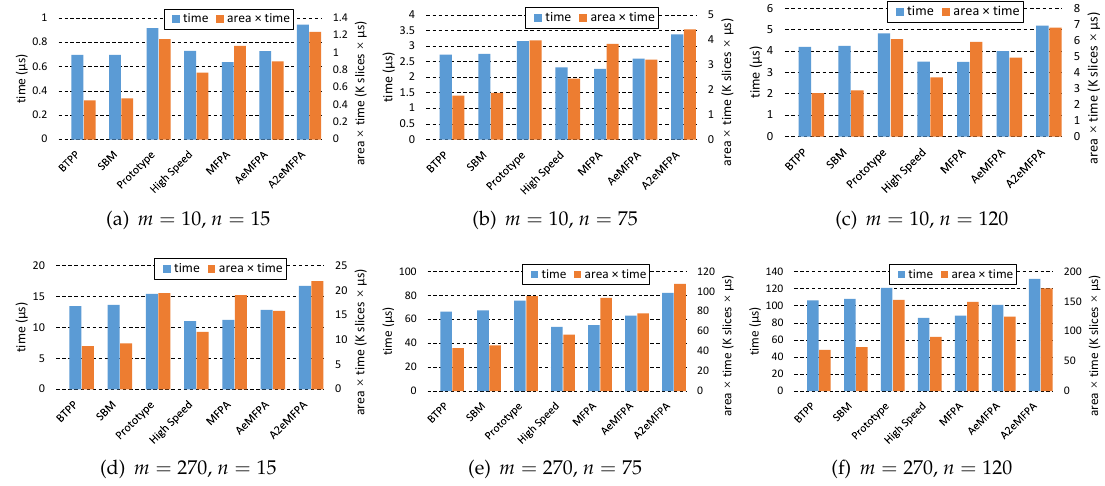
Figure 12. The comparison of execution time and area-time product between different designs, where p = 14. To prove that the BTPP can be used for different reduction operators, we give pre- synthesis simulation examples of BTPP using an adder and a multiplier, respectively, in x i and ∏ n − 1 x i , which are the main Figure 13. Since the most common problems are ∑ n − 1 i = 0 i = 0 problems solved by the reduction circuit, we chose adder and multiplier as the reduction operator. The adder and multiplier are IPs generated by Xilinx Vivado 2019.1 software, their data are double-precision floating-point numbers, and the number of pipeline stages is 14. The circuit is implemented in Verilog HDL, and is simulated by ModelSim called by Vivado. Data sets { 1, 2, 3 } , { 1, 2, 3, 4 } , { 1, 2, 3, 4, 5 } , and { 1, 2, 3, 4, 5, 6 } are the test. It can be seen from the figure that the input signals of Figure 13a,b are the same, and the time for dout _ valid to become valid is also the same. At 256ns, both circuits output the calculation results of the last data set. The output of Figure 13a is 21 ( = 1 + 2 + 3 + 4 + 5 + 6), and the output of Figure 13b is 720 ( = 1 × 2 × 3 × 4 × 5 ×